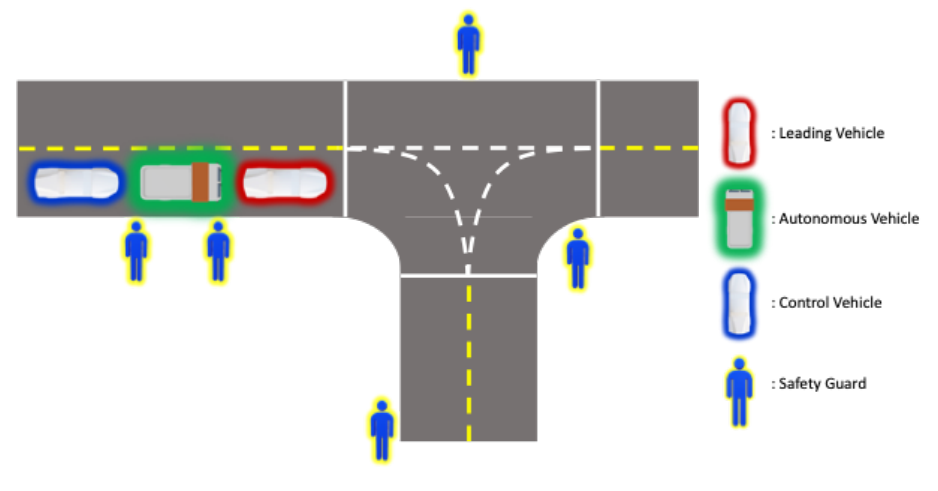
Figure 20. Safety plan.